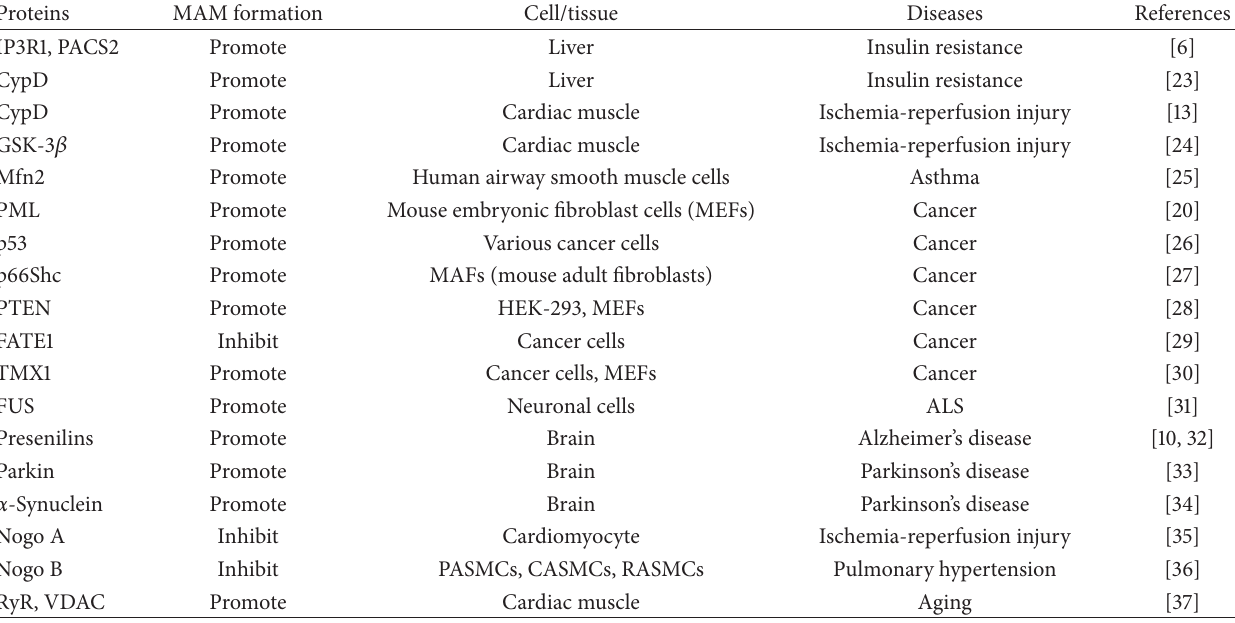
Table 1: MAM-resident proteins linked with metabolic and inflammatory